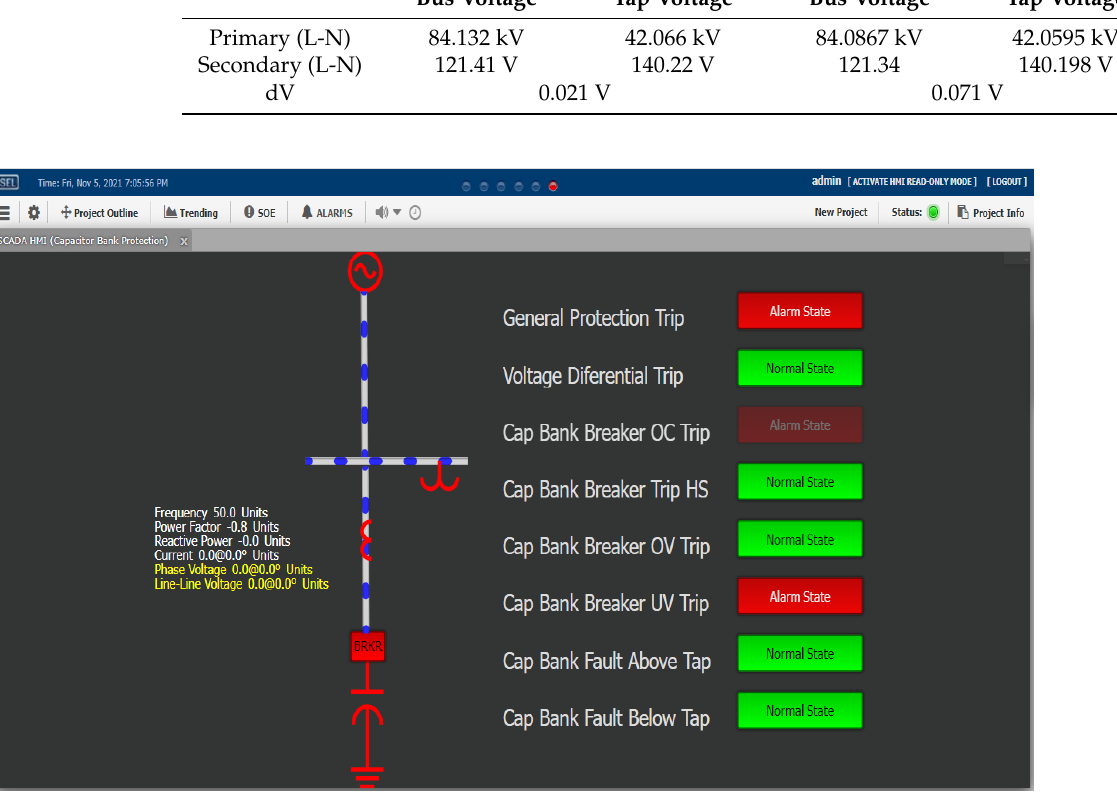
Figure 9. A human-machine interface for a simultaneous failure of six element failures above and below the tap.